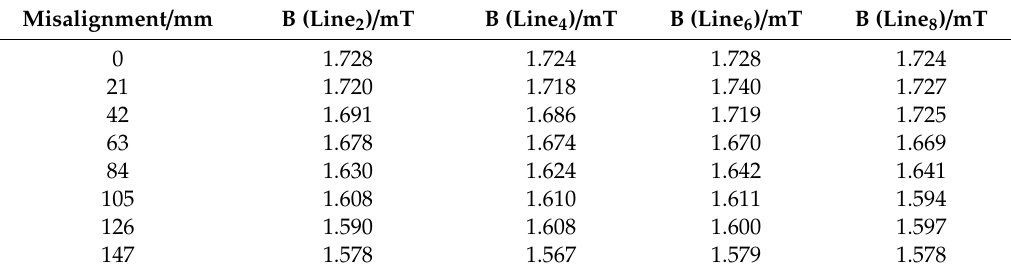
Table 4. Magnetic flux density B with di ff erent misalignment (Line 2 , Line 4 , Line 6 , Line 8 ).